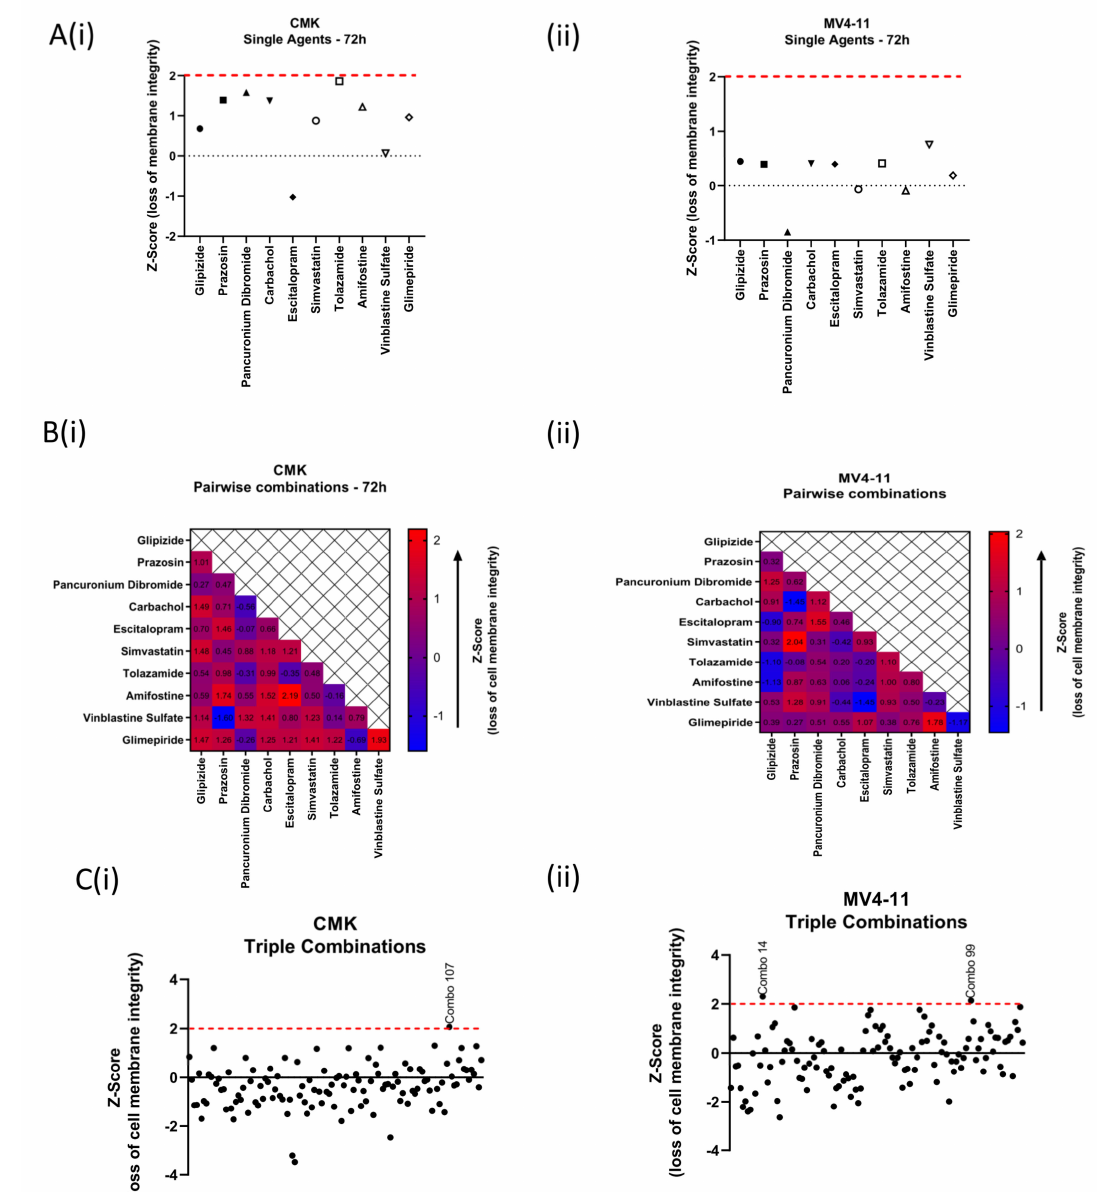
Figure 2. Secondary deconvolution screen of Plate 13 Well 115 into pairwise and triple combinations. The 10 compounds within this well were deconvoluted into 45 pairwise combinations and 120 triple combinations. The viability of these combinations was tested over a period of 72 h at a final concentration of 0.1 µ M with the exception of vinblastine sulfate, which was tested at a final concentration of 0.001 µ M. ( A ) Graphical representation of the Z-score of each of the 10 compounds as single agents alongside the Z-score of the 10-compound combination. ( i ) CMK; ( ii ) MV4-11. ( B ) Heatmap demonstrating the Z-score of each of the 45 pairwise combinations. ( i ) CMK; ( ii ) MV4-11 ( C ) Graph demonstrating the Z-score of the 120 triple combinations. ( i ) CMK; ( ii )